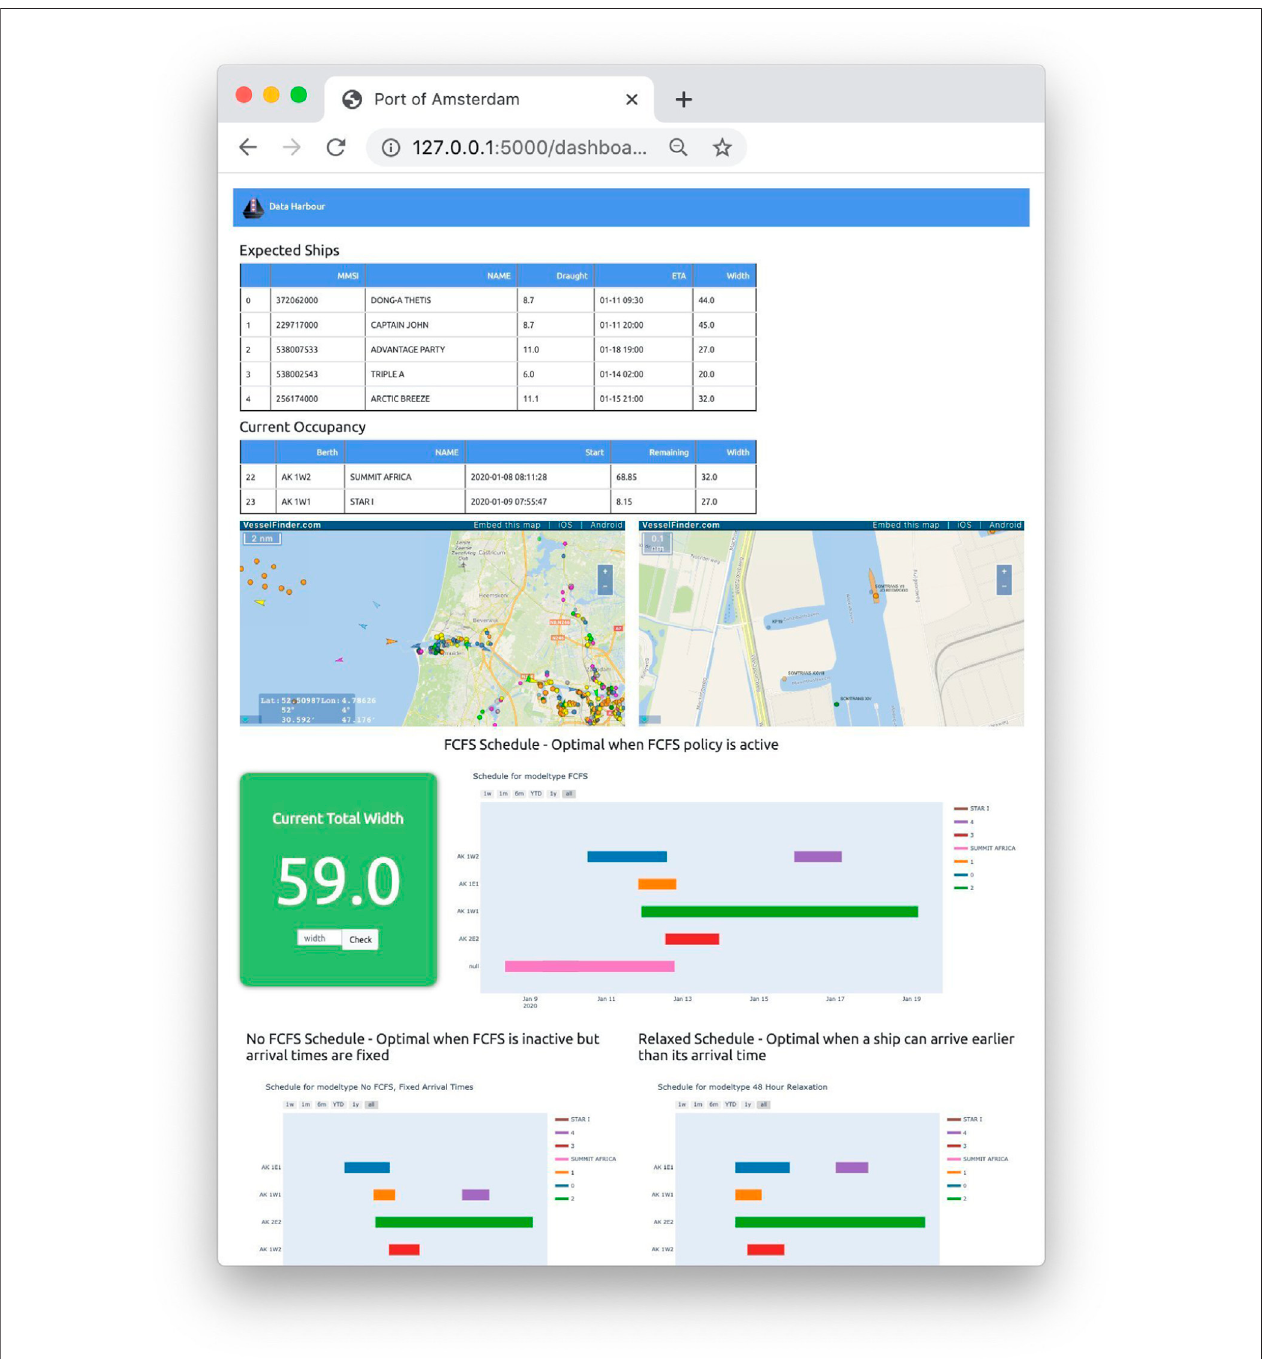
FIGURE 7 | Preview of the dashboard (note that this runs